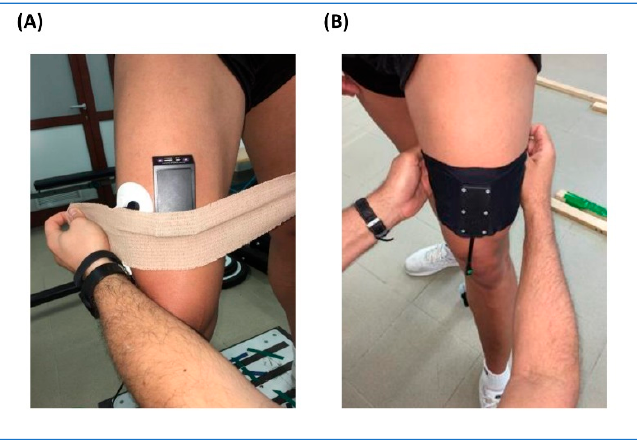
Figure 3. Sensor positioning. ( A ): PortaMon and MuscleLab; ( B ): wiNIREM.